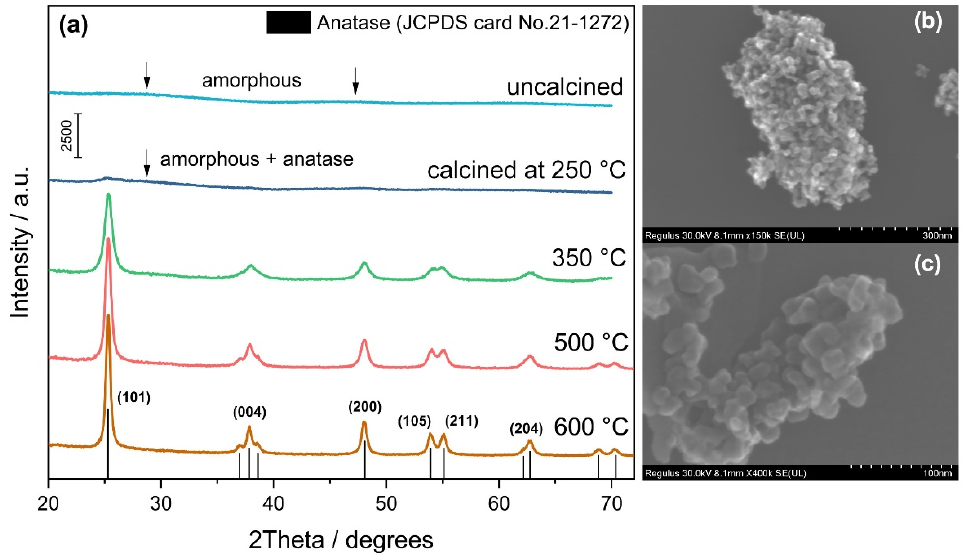
Figure 1. XRD patterns of TiO 2 -N samples calcined at different temperatures ( a ) and SEM micro- graphs of the sample calcined at 350 °C ( b , c ).